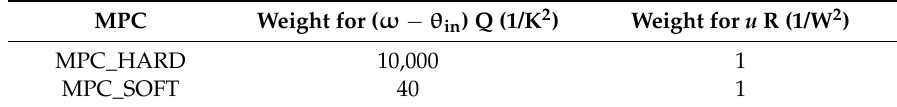
Table 2. Weight values used in the Model Predictive Controls